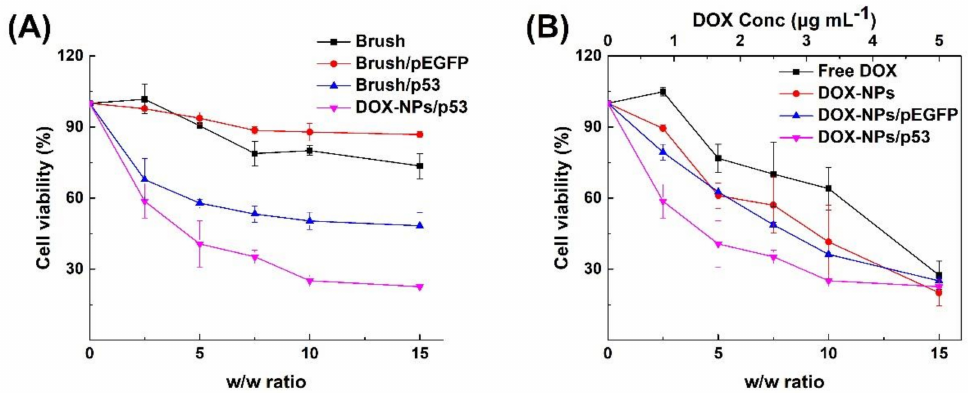
Figure 6. In vitro cytotoxicity against MCF-7 cells: ( A ) samples containing the polycationic brush (Brush, Brush/pEGFP, Brush/p53 and DOX-NPs/p53 complexes); and ( B ) samples containing DOX (free DOX, DOX-NPs, DOX-NPs/pEGFP and DOX-NPs/p53